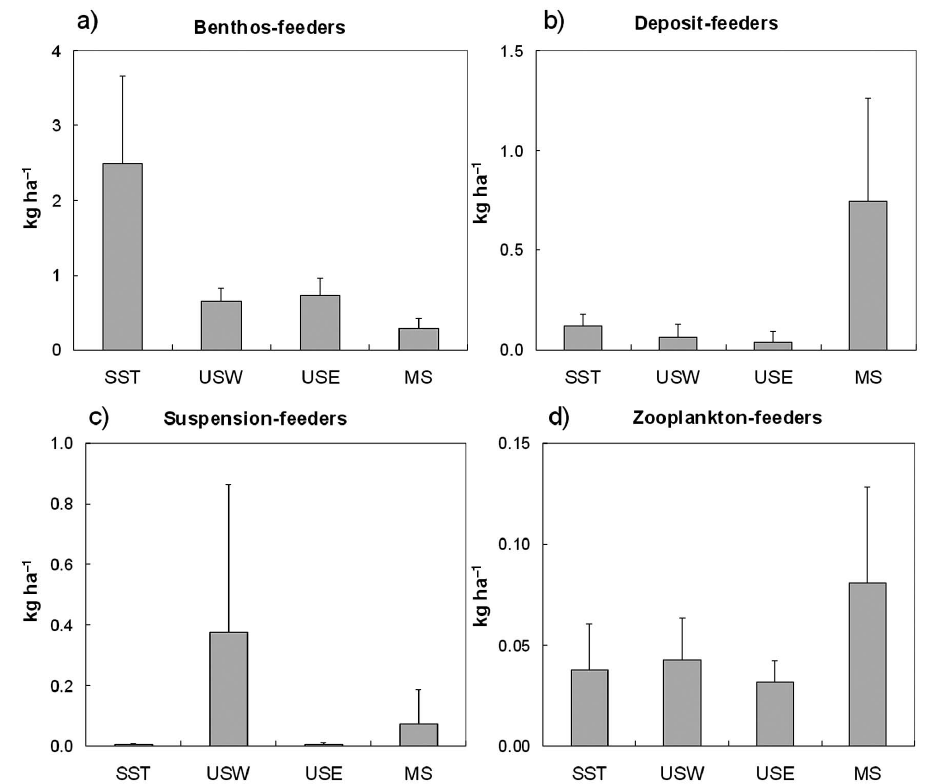
Fig . 6. – Invertebrate species trophic guild composition in the cluster groups in terms of biomass.